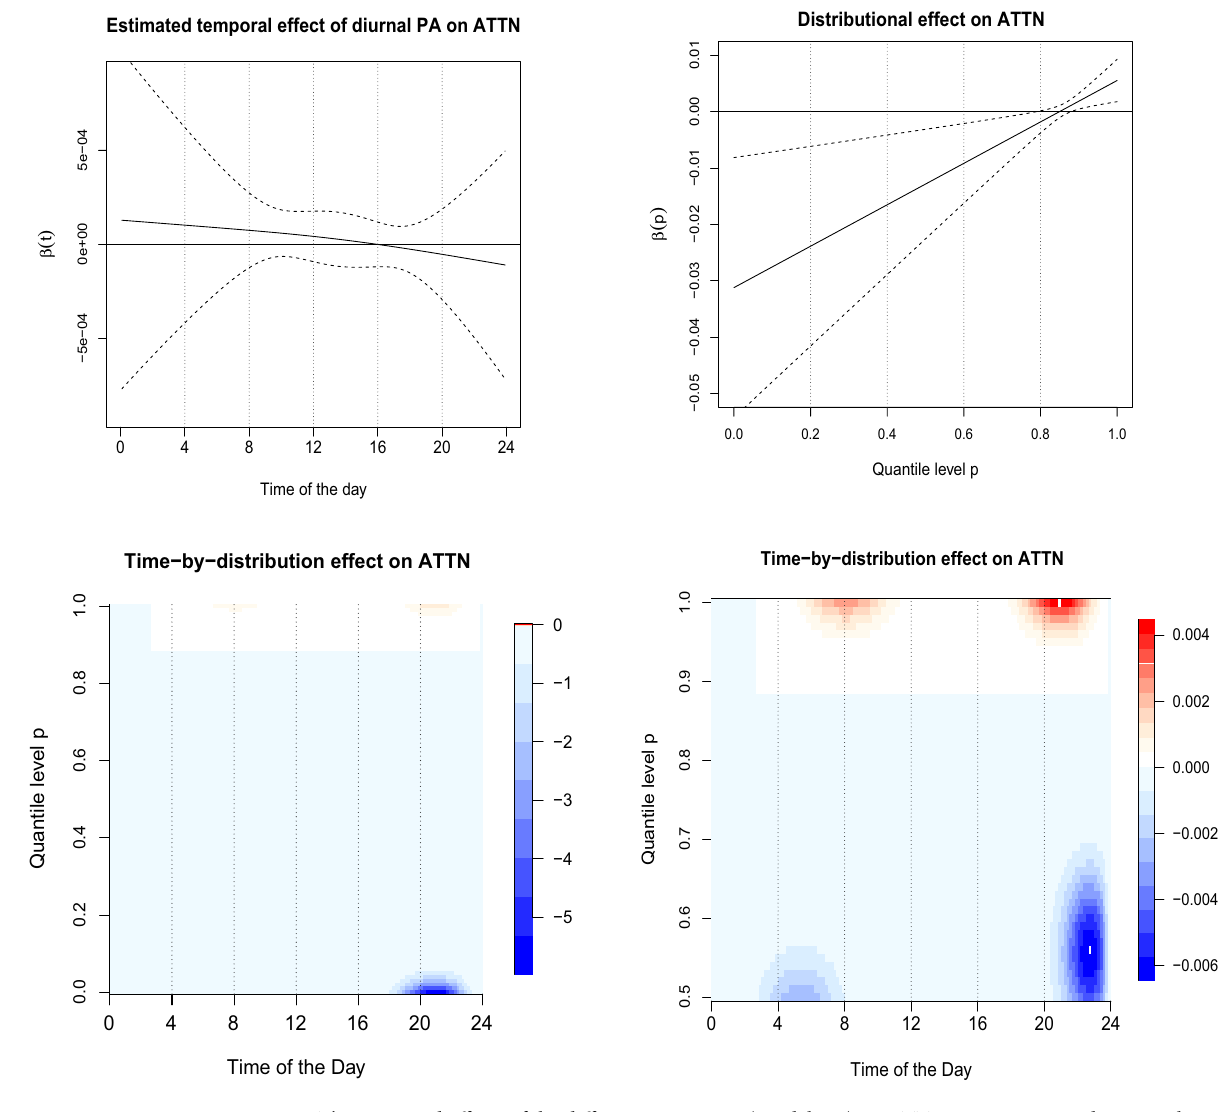
Figure 6. The estimated effects of the different PA metrics (Model 2-4) on ATTN score. Estimated temporal effect (solid line) β( t ) (top left). Estimated distributional effect β( p ) (top right). Estimated bivariate effect β( t , p ) of time-by-distribution PA surface (bottom left). The same plot (zoomed-in) with p restricted to the distributional domain (0.5, 1) (bottom